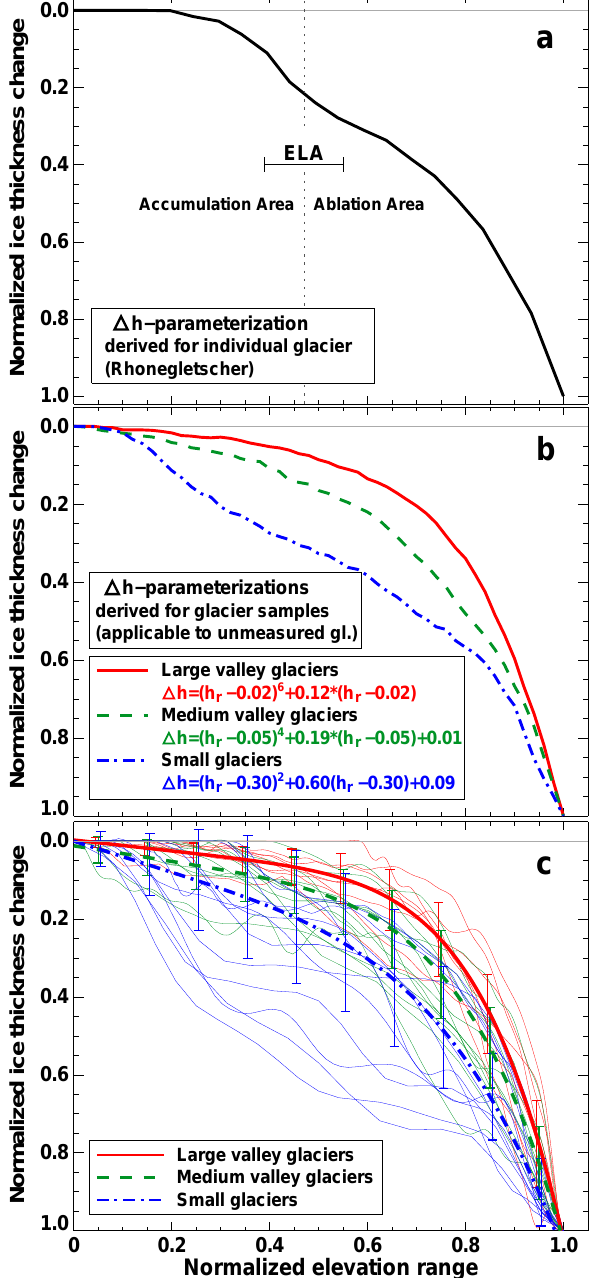
Fig. 3. (a) ∆ h -parameterization derived for Rhonegletscher from observed ice thickness changes in the 20th century. The variability in the equilibrium line altitude (ELA) is shown. (b) Empirical ∆ h -parameterizations for three glacier size classes applicable to unmeasured glaciers derived from digital elevation model comparison for 34 glaciers. The equations refer to a numerical approximation (according to Eq. 1) of the line for each size class. (c) Approximations (see (b) for equations) including individually derived parameterizations for all 34 glaciers (thin lines). The colour indicates the size class. Error bars show the uncertainty of the approximation; they are calculated as the standard deviation of the individual parameterizations within the size class.